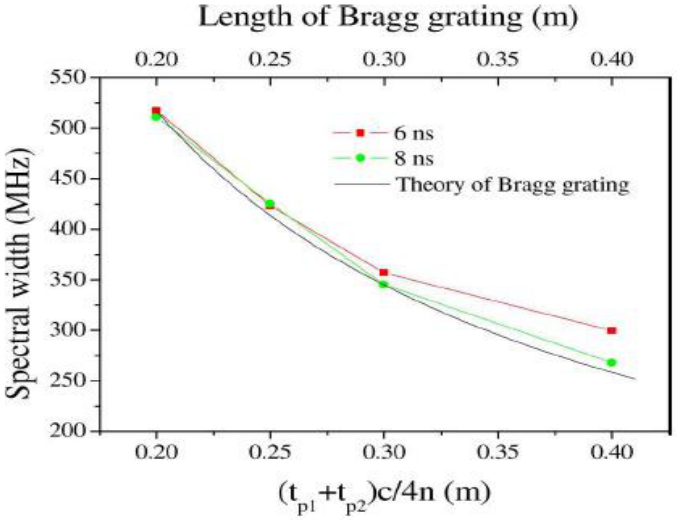
Figure 12. The intrinsic Brillouin grating spectral width as a function of length [71] (Copyright © 2010 OSA, Reprinted with